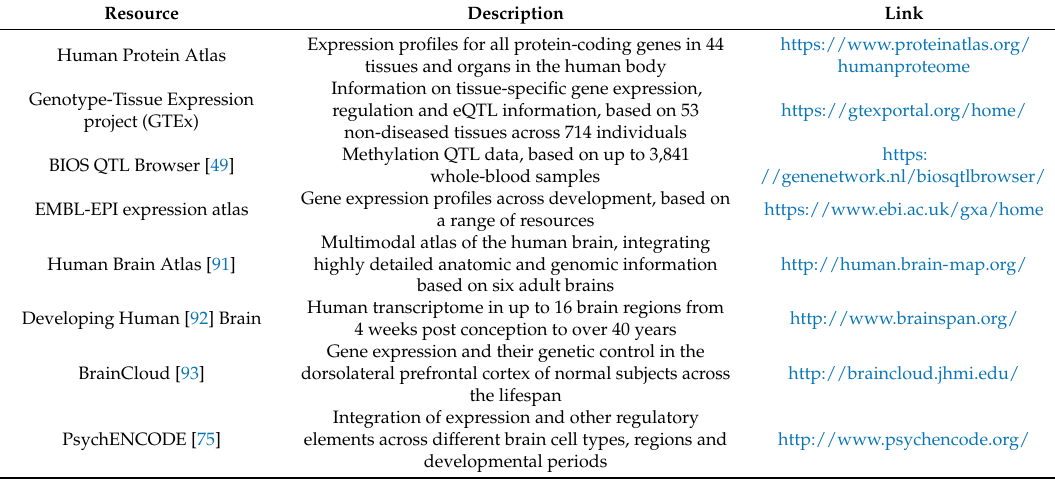
Table 7. Resources to investigate tissue-specific gene expression. eQTL: expression quantitative trait